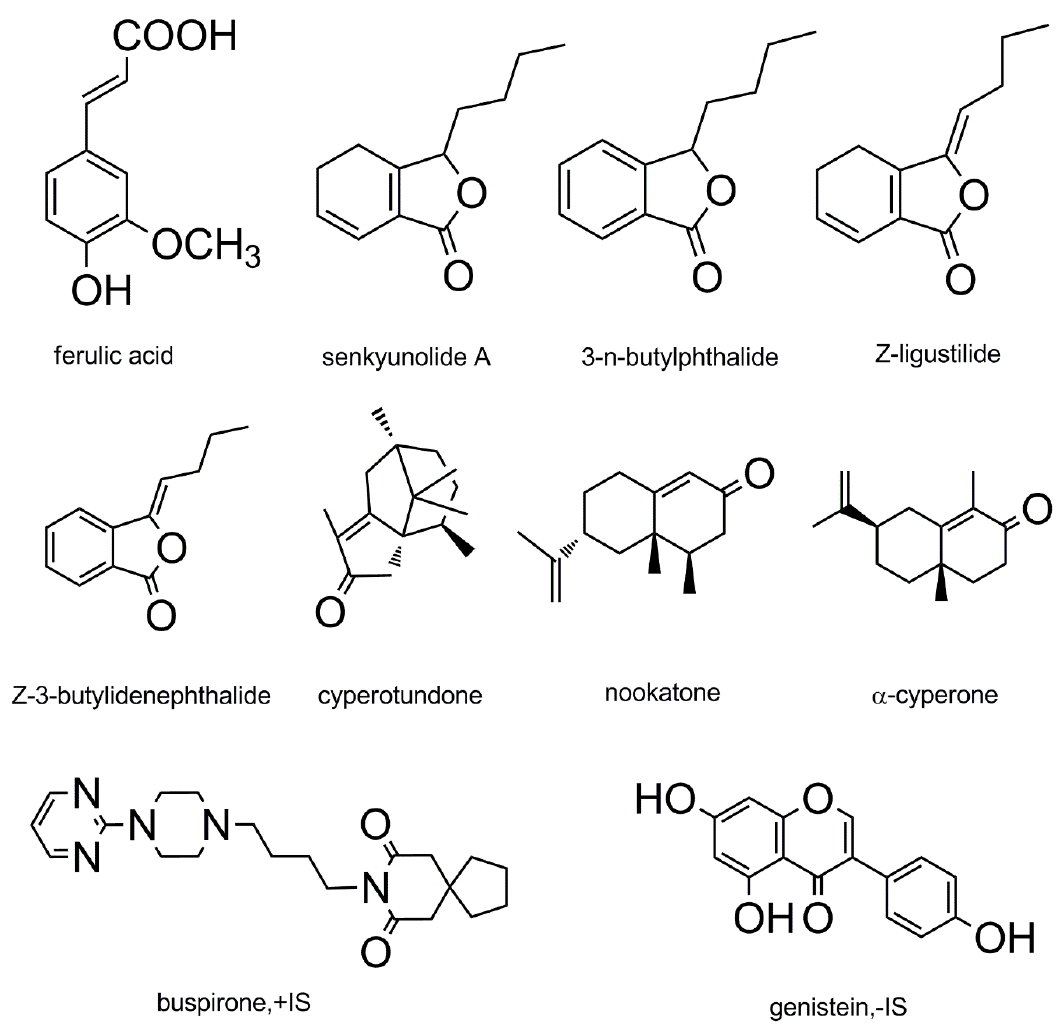
Figure 7. Chemical structures of FA, SA, NBP, LIG, BDPH, CYT, NKT, CYP, BUS and GEN.